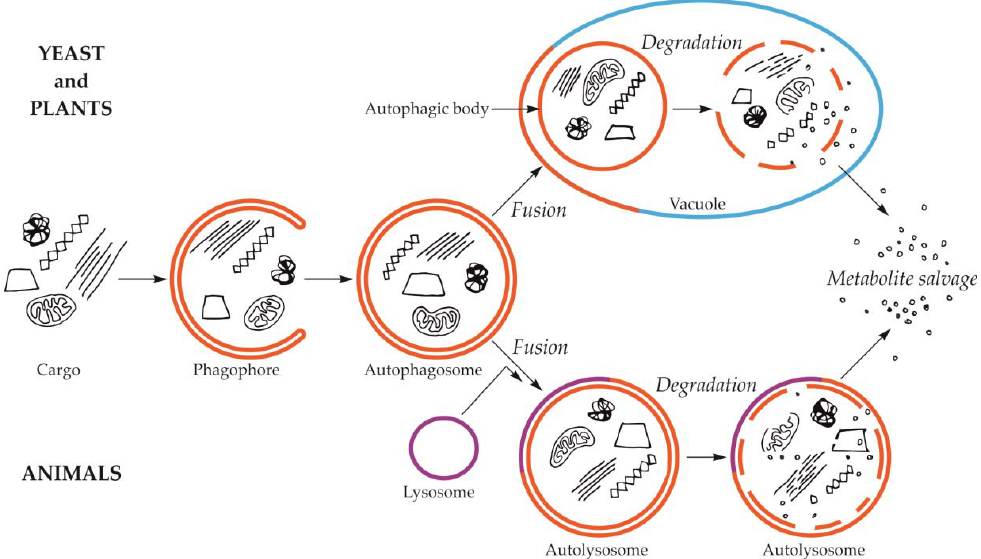
Figure 1 . Schematic diagram of macroautophagy in cells of yeast and plants (upper part of the drawing) and in cells of animals (bottom part of the drawing). In yeast and plant cells, the autophagosome fuses to the tonoplast, creating the autophagic body inside the vacuole. In animal cells, the autophagosome fuses with the lysosome, giving the autolysosome. The autophagic body inside the vacuole and the content of autolysosome are rapidly degraded, allowing reuse of